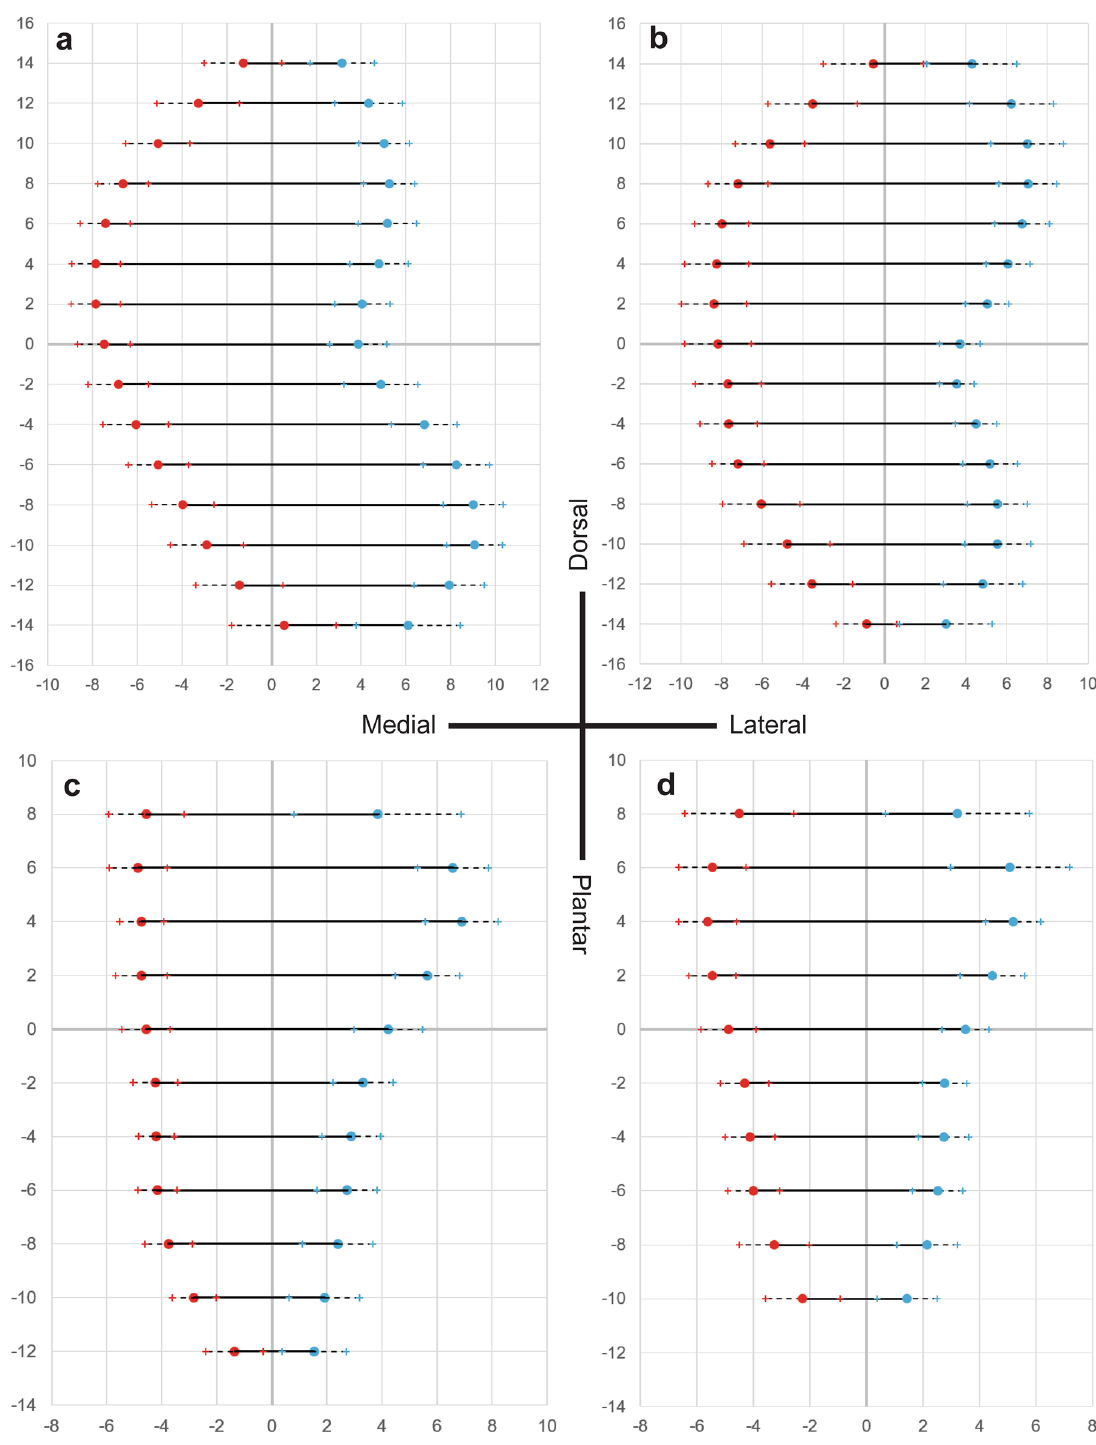
Figure 3. Distance measurements of articular surface depth at varying heights with 2 mm separation in the ( a ) medial cuneiform, ( b ) first metatarsal, ( c ) intermediate cuneiform, and ( d ) second metatarsal. Medial distances (mm) are given in red and lateral distances (mm) given in blue and whiskers show plus and minus one standard deviation for each measure. Only heights with at least 12 measurements are